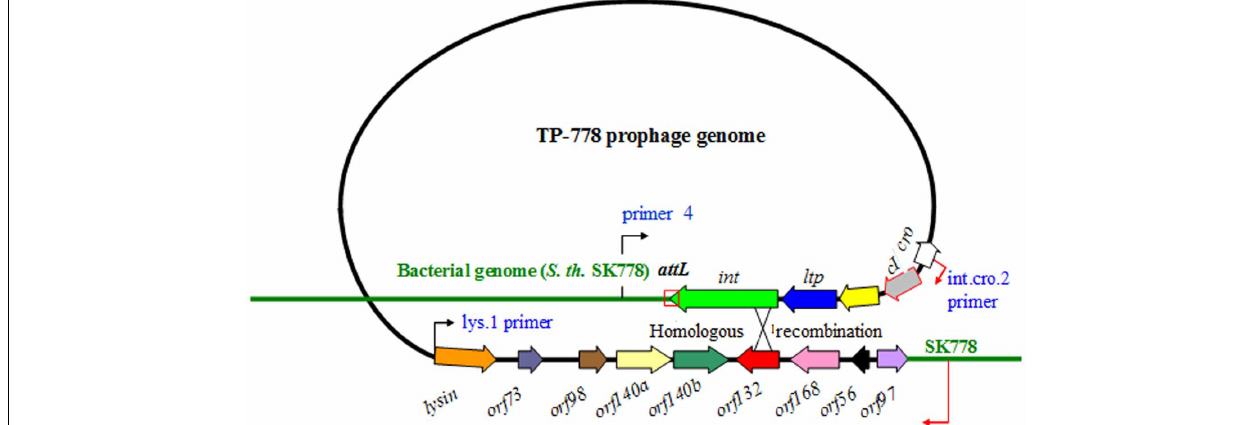
by arrows. Binding sites of primers 4 and 3 (Bruttin et al., 1997 are shown). The region of predicted cross-over is indicated by a